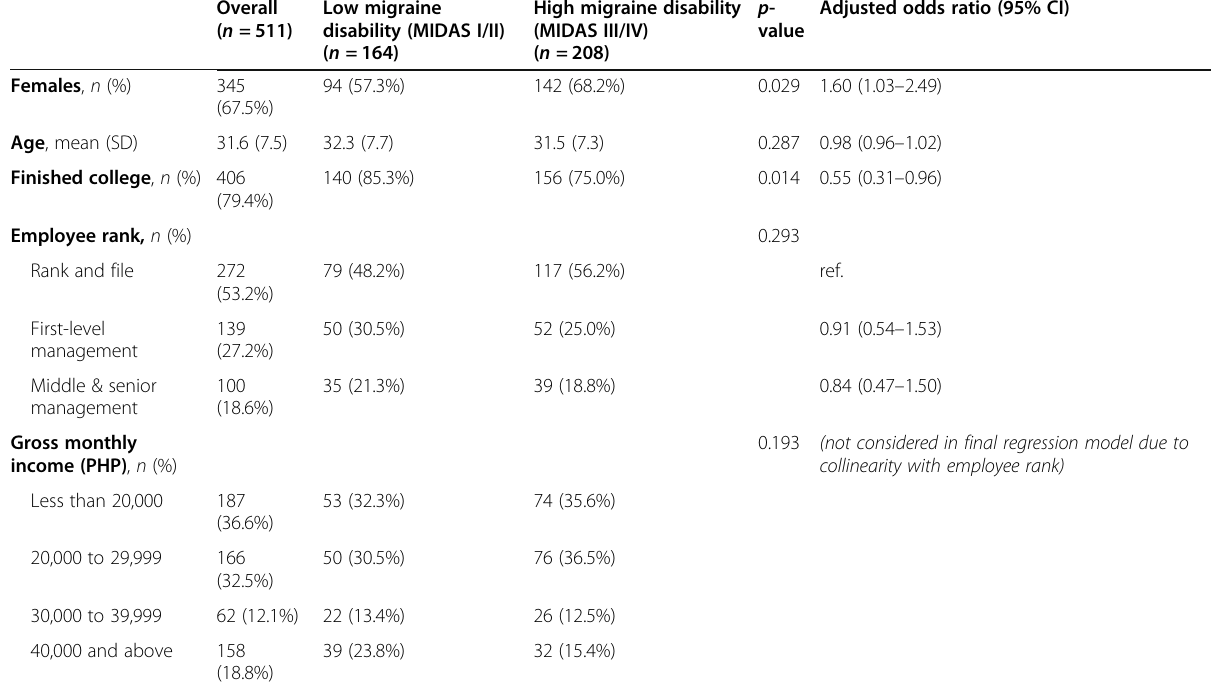
Table 1 Demographics of positive migraine screens and association with high migraine disability ( n =